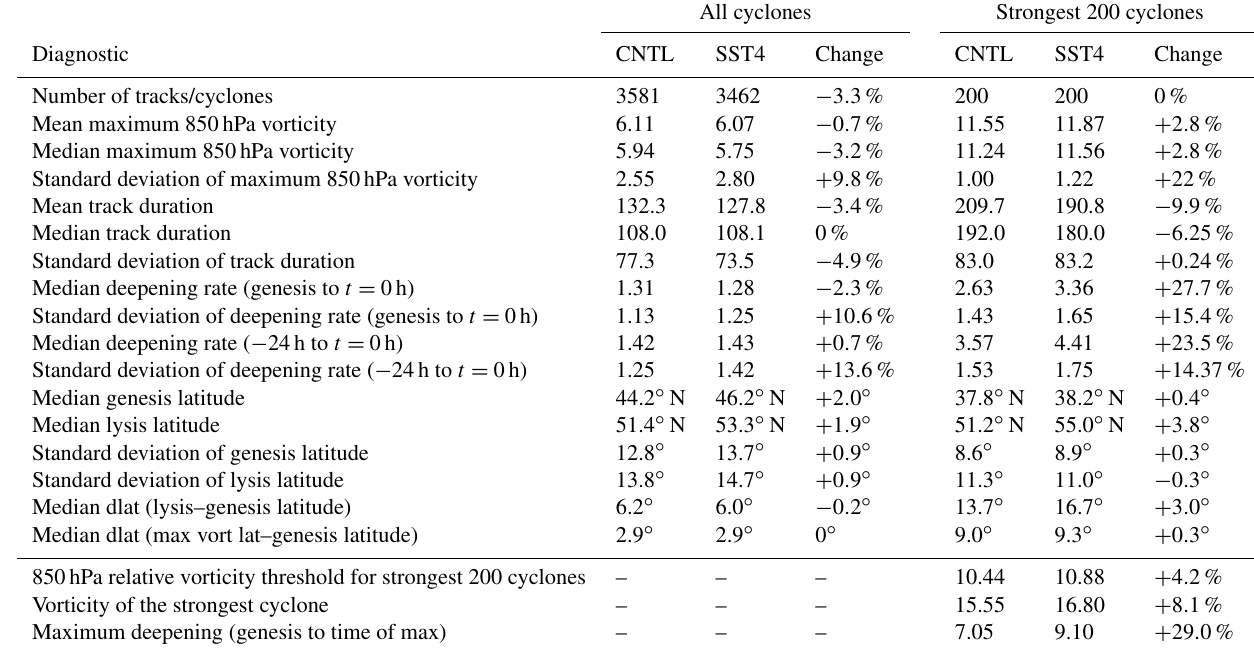
Table 1. Cyclone statistics from CNTL and SST4. Relative vorticity values have units of × 10 − 5 s − 1 . Duration (lifetime) is given in units